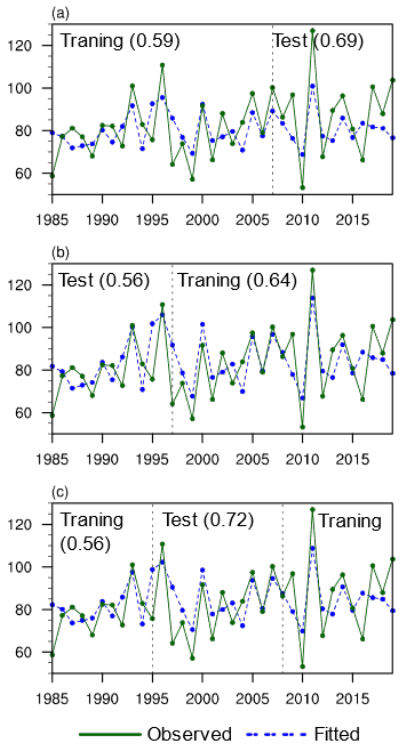
Figure 10. ( a ) Observed April PENA (green line, mm/month) and fitted April PENA variations (blue line, mm/month) established by the linear regression model for March ASO during 1985–2019. The training period is 1985–2007 and the independent test period is 2008–2019. ( b ) Same as ( a ), but with a training period of 1997–2019 and independent test period of 1985–1996. ( c ) Same as ( a ), but with an independent test period of 1996–2007 and the other years are used for the training period. The numbers in parentheses represent the correlation coefficients.